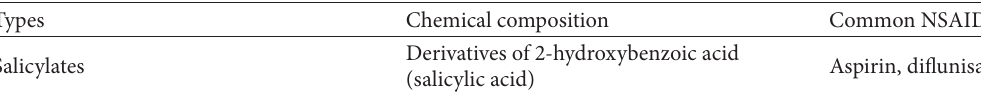
Table 1: Classification of